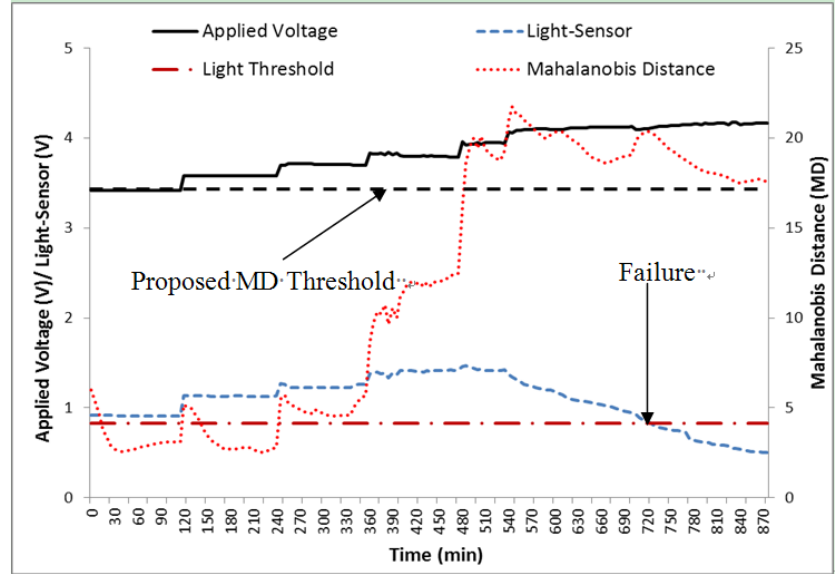
Figure 12. Mahalanobis Distance analysis for sensor